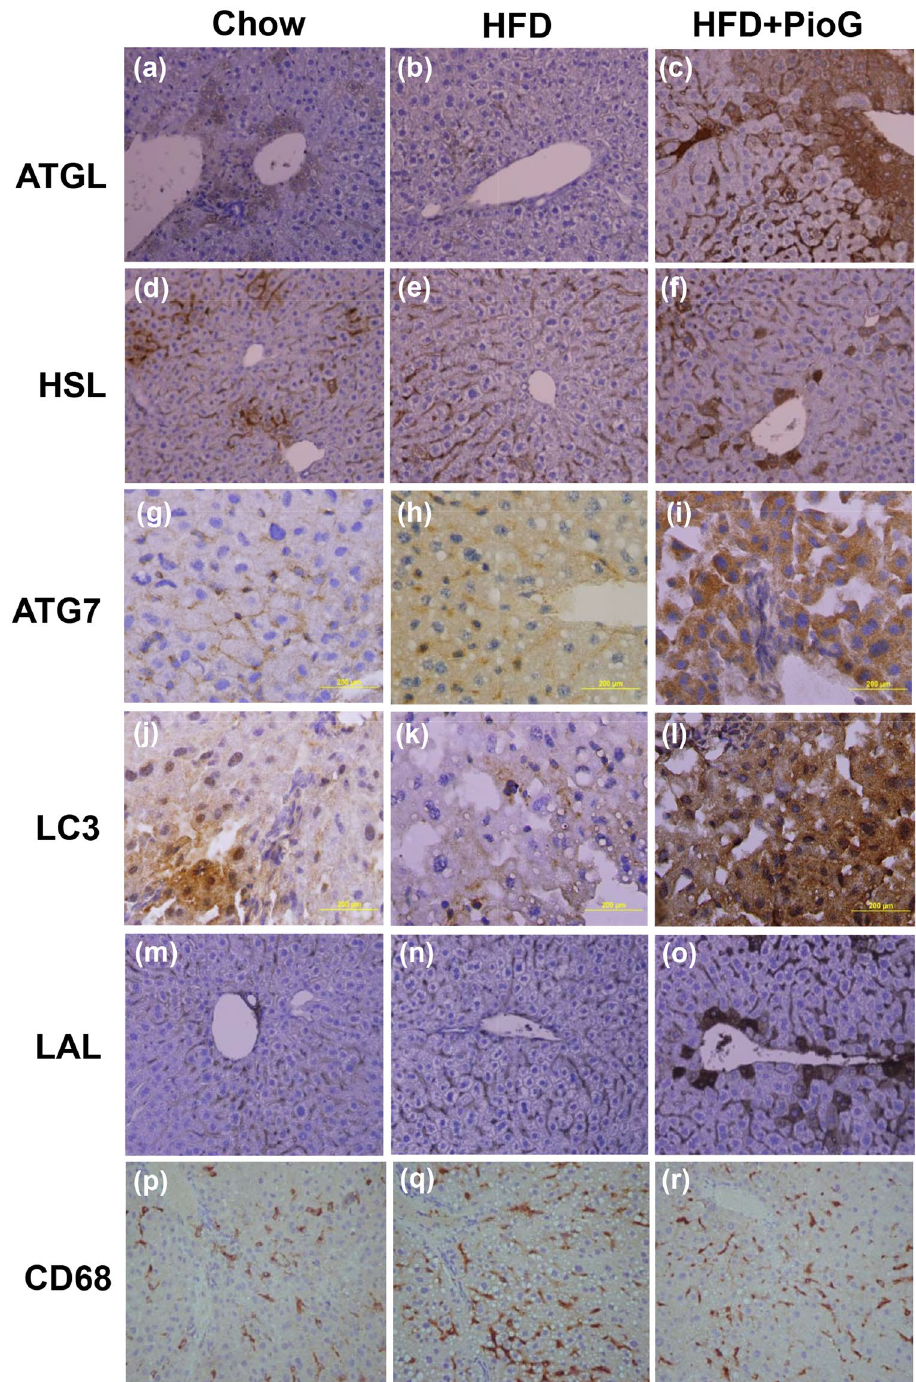
Figure 3. Pioglitazone increased immunochemical expressions of cytosolic lipolysis and autophagy-related proteins. The liver specimens were stained by antibodies against ATGL, HSL, ATG7, LC3, and LAL separately conditioned by chow diet, high fat diet, and high fat diet co-administered with pioglitazone (PioG, 100 mg/ kg/d) for 8 weeks. Kupffer cell was characterized by CD68 staining. Magnifications, ( a – f ): 400X, ( g – l ): 1000X, ( m – o ): 40X, ( p – r ):